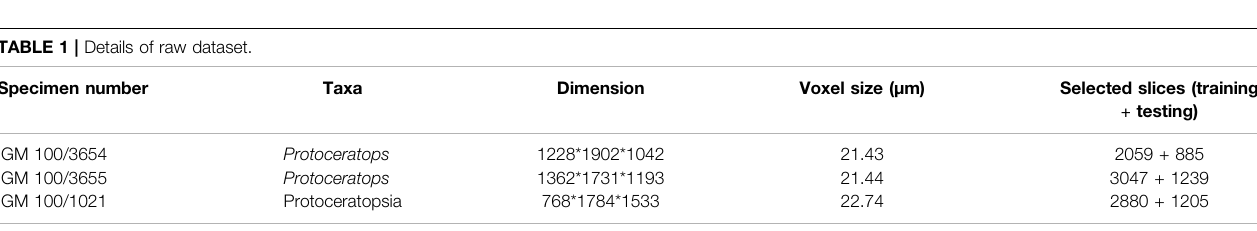
TABLE 1 | Details of raw dataset.